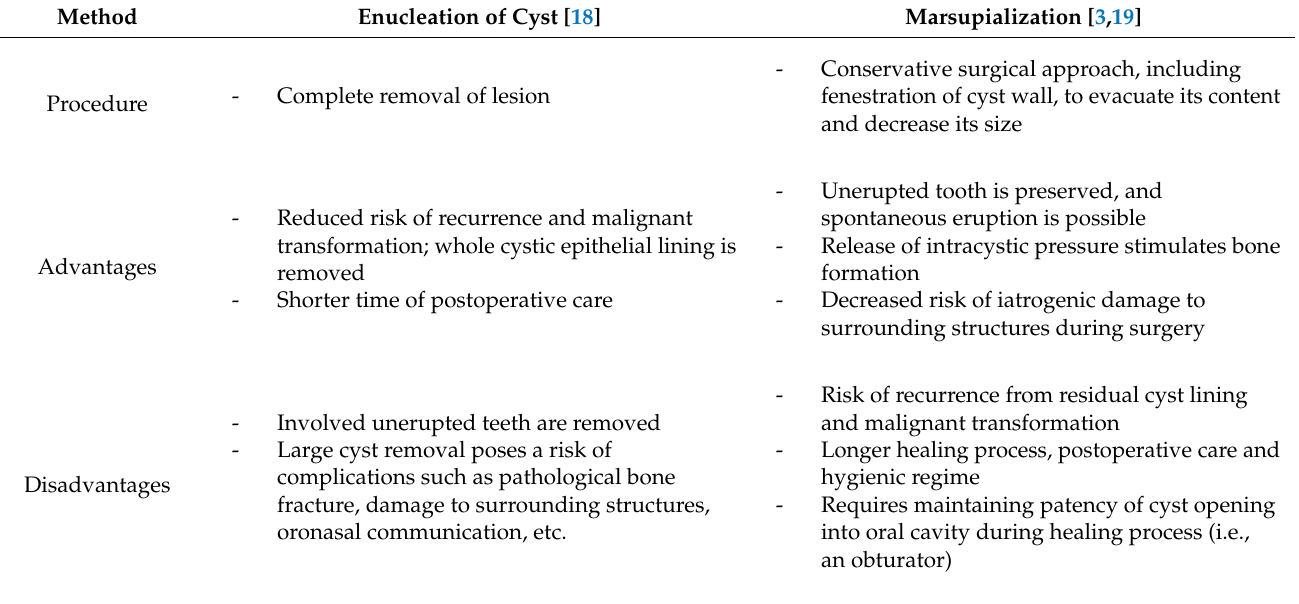
Table 2. Two main surgical treatment methods for cyst-like odontogenic